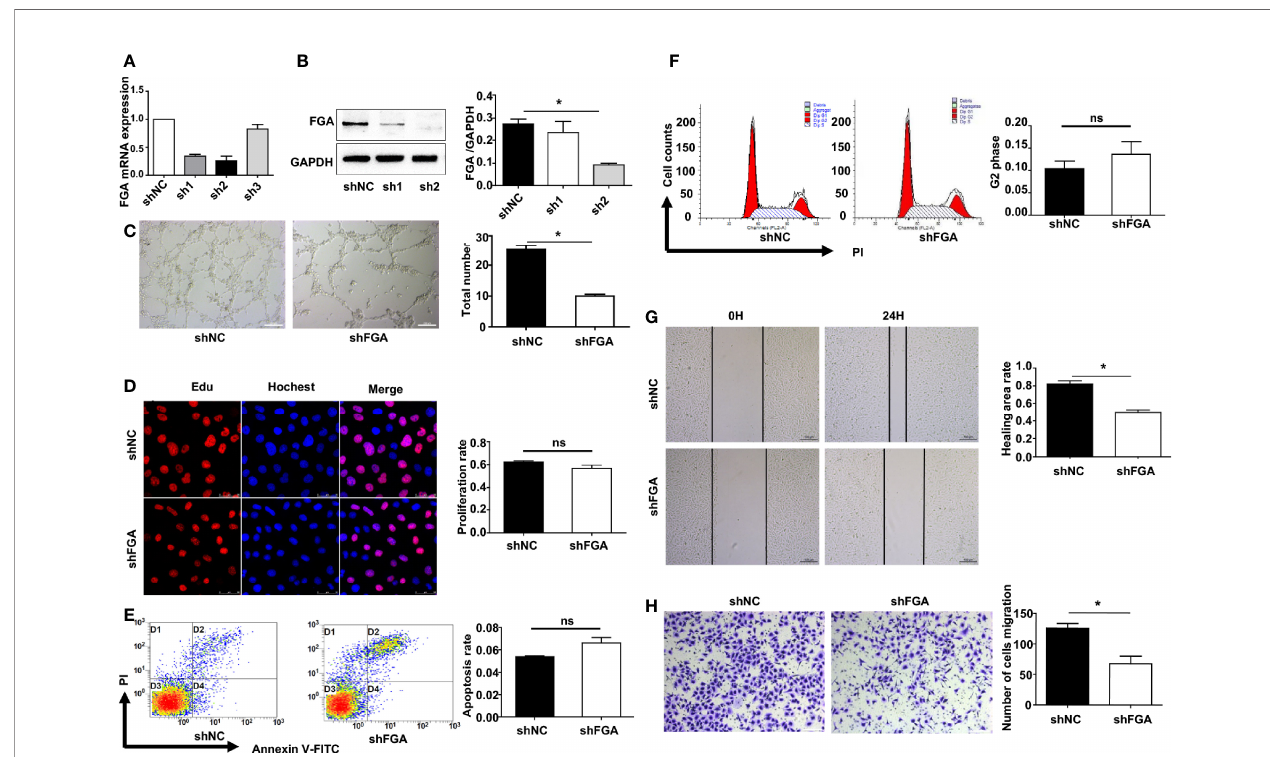
FIGURE 2 | Effect of the conditioned medium (CM) of hEM15A with FGA knockdown on HUVECs. (A, B) The expression levels of FGA mRNA and protein were assessed by RT-PCR (A) and Western blot analysis (B) after transfection with sh1, sh2, sh3 and shNC in hEM15A, and sh2 was selected for use in the subsequent experiments as shFGA. (C) Tube formation assay. HUVECs were plated on Matrigel in CM of hEM15A shNC or hEM15A shFGA cells and then were observed under microscope after incubating for 4h; (left) Representative images of tube, bar=200 m m. (right) Quantitative analysis of total tube number. (D) Edu assay showing the proliferation of HUEVCs treated with CM from hEM15A shNC and hEM15A shFGA cells for 24h. (E, F) Flow cytometry analysis showing that apoptosis rate (E) and cell cycle (F) of HUEVCs treated with CM from hEM15A shNC and hEM15A shFGA cells for 24h. (G, H) Scratch assay (G) and transwell assay (H) were conducted to assess migration ability of HUEVCs treated with CM from hEM15A shNC and hEM15A shFGA cells for 24h . * P <0.05, ns: not signi fi cant, P ≥